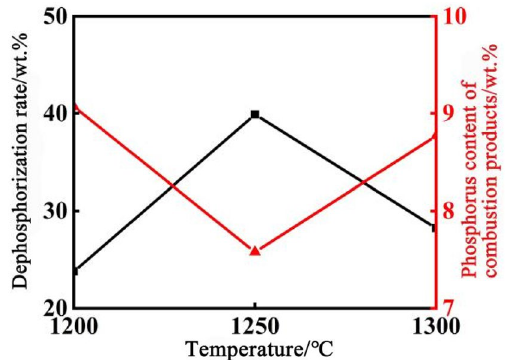
Fig. 4 Phosphorus content and dephosphorization rate of roasting products at different temperatures